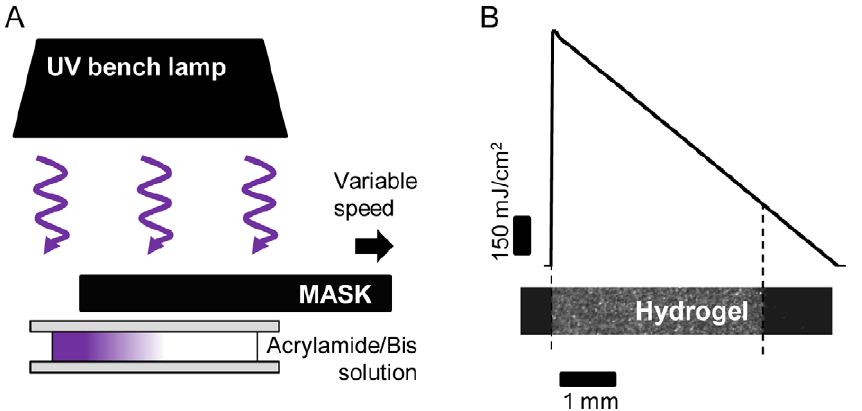
Figure 1. Sketch of the experimental setup. (A) To produce hydrogels with a stiffness gradient, we irradiate an acrylamide/bis-acrylamide solution, containing Irgacure, confined between two coverslips of , 170 m m thickness ( # 1). The sample initially is protected by an opaque mask. An irradiation gradient is obtained by moving the mask (in the direction of the arrow) while illuminating the solution with a non-collimated UV lamp (365 nm). (B) Linear irradiation gradient obtained by moving the opaque mask at a constant speed. Any arbitrary, monotonically decreasing irradiation pattern can be generated by changing the mask speed during the polymerization process.